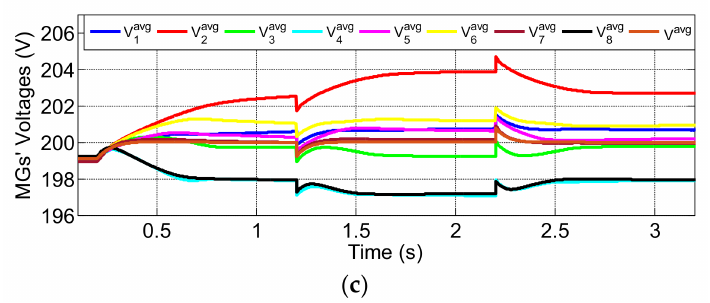
Figure 11. Scalability confirmation: ( a ) DGs’ output powers, ( b ) DGs’ incremental costs, and ( c ) Aver- age voltages across the